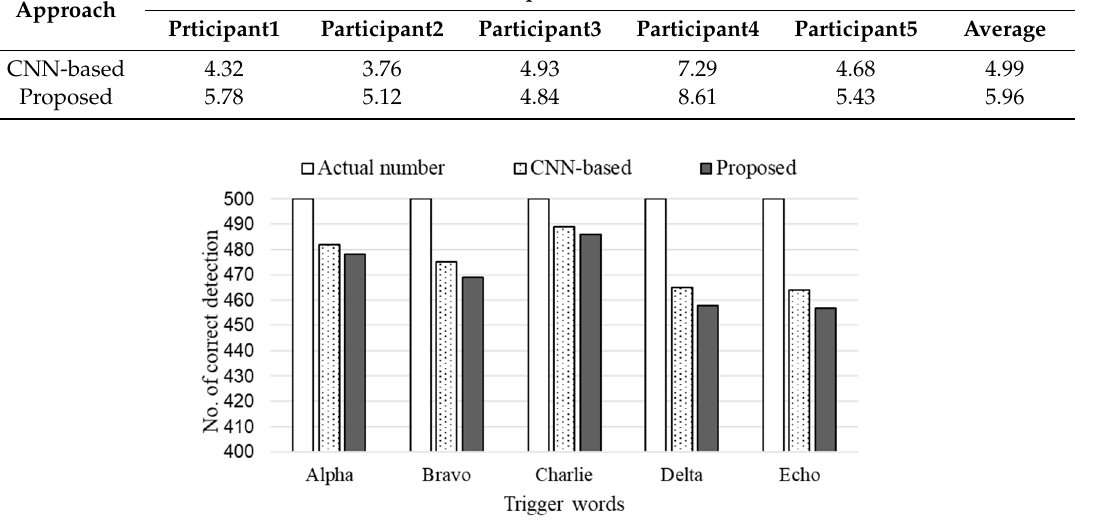
Figure 15. Detection accuracy of each trigger word.